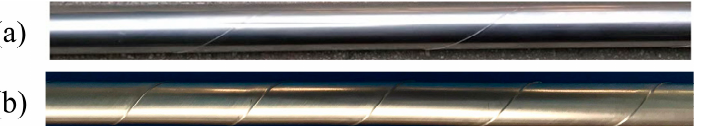
Figure 2. The schematic diagram of the winding procedure ( a ) and its core model structure ( b ).